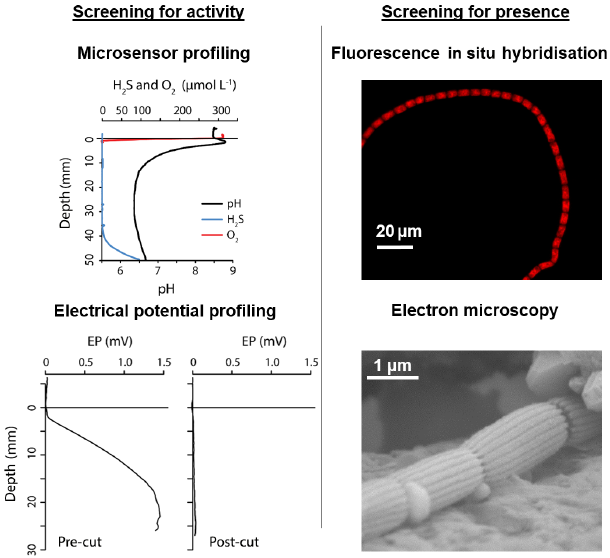
Figure 2. Overview of the methods that demonstrate cable bacte- ria activity (left column) and cable bacteria presence (right col- umn) in aquatic sediments. Microsensor profiling produces high- resolution depth profiles of pH, H 2 S and O 2 , which reveal the char- acteristic geochemical fingerprint of electrogenic sulfur oxidation (pH excursions and suboxic zone). Electrical potential profiling di- rectly demonstrates the build-up of the electrical potential in the sediment due to long-distance electron transport (Damgaard et al., 2015; Risgaard-Petersen et al., 2015). Passing a thin wire through the sediment cuts the cable bacteria filaments and confirms that the observed build-up of the electrical potential is due to cable bacteria activity. The presence of cable bacteria can be confirmed by RNA staining (FISH probe DSB706) or by electron microscopy, which reveals the parallel ridges on the cell envelope that are unique to cable